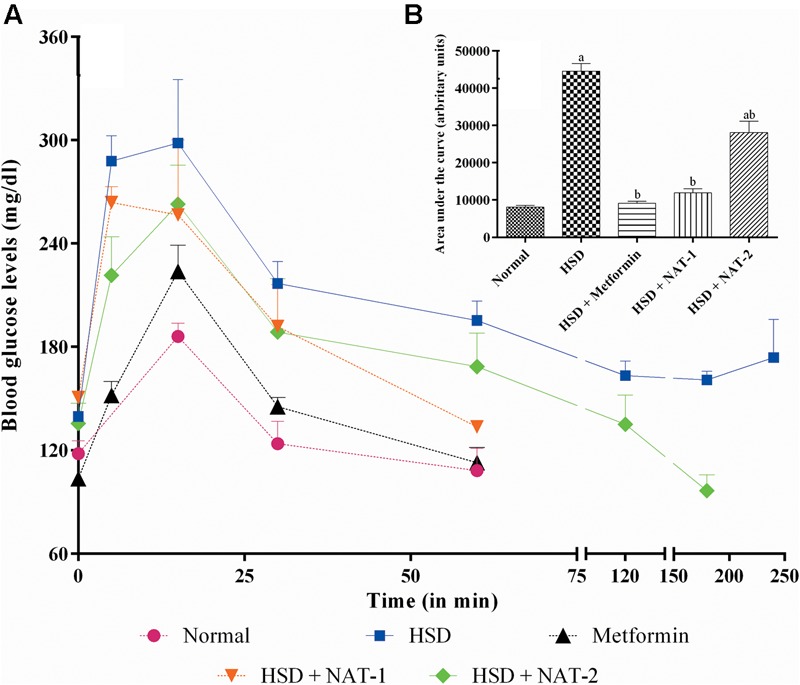
Effect of 15-month high sucrose diet (HSD) on OGTT after a glucose load (2 g/kg, b.w.), where
(A) plot of plasma glucose levels (mg/dl) vs. time interval; (B) area under the curve (AUC; expressed as arbitrary units) of the glucose tolerance curve. The time taken for the plasma glucose levels to come back to their pre-glucose-load values were considered for calculation of AUC. All values are expressed as mean + SEM (n = 5–6). ap < 0.05 compared to normal control; bp < 0.05 compared to HSD control. In OGTT, after the glucose load in the normal diet fed group, the basal plasma glucose levels were attained in less than 60 min whereas in HSD fed group, the basal levels were was not attained even after 4 h. With metformin and NAT-1 treatment, the basal blood glucose was attained in 60 min and in 2 h by NAT-2 treatment.